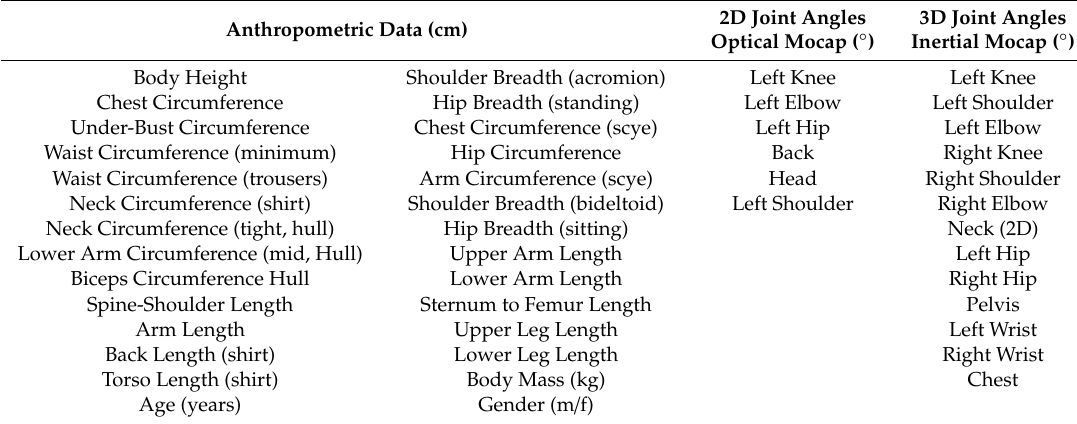
Table 1. List of participant data that was recorded from measurements and optical and inertial motion